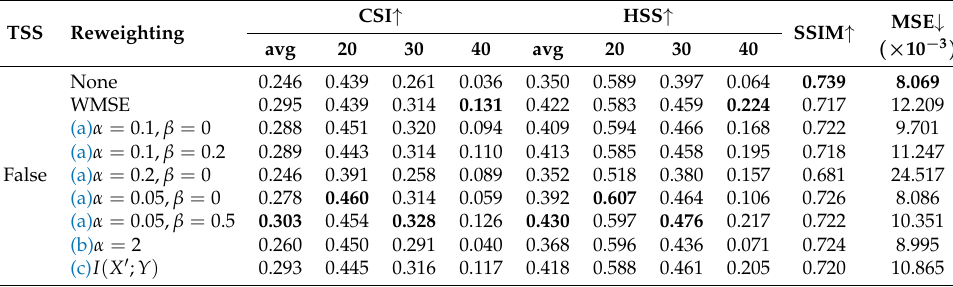
Table 5. MIR strategies on HKO-7. False TSS stands for the t fixed to 10.